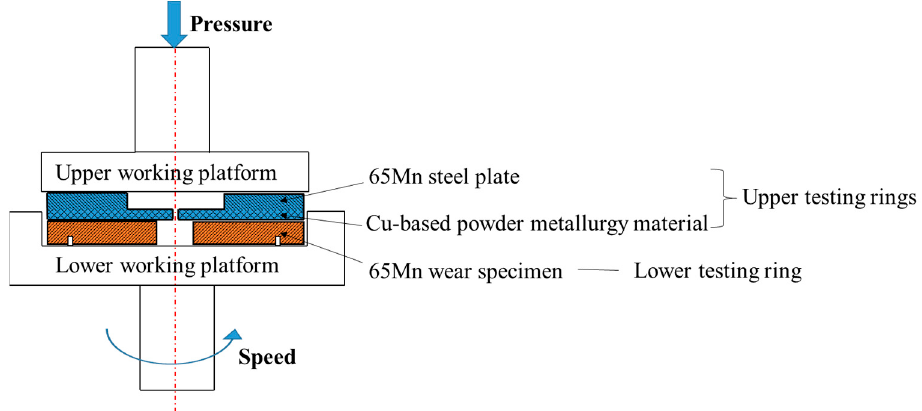
Figure 7. Schematic illustration of wear tests.